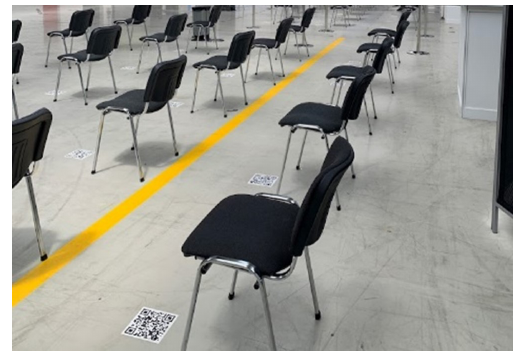
Figure 1: QR code at the vaccination centre Winterthur (Source: Impfzentrum Winterthur,